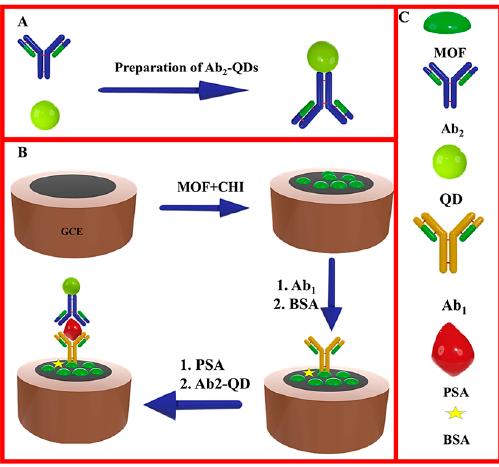
Figure 8. Enzyme-free immunosensor platform based on the Fe 3 O 4 @ TMU-10 MOF magnetic system and nickel-cadmium quantum dots for detection of PSA. Reproduced from [165] with permission from Elsevier, 2020.